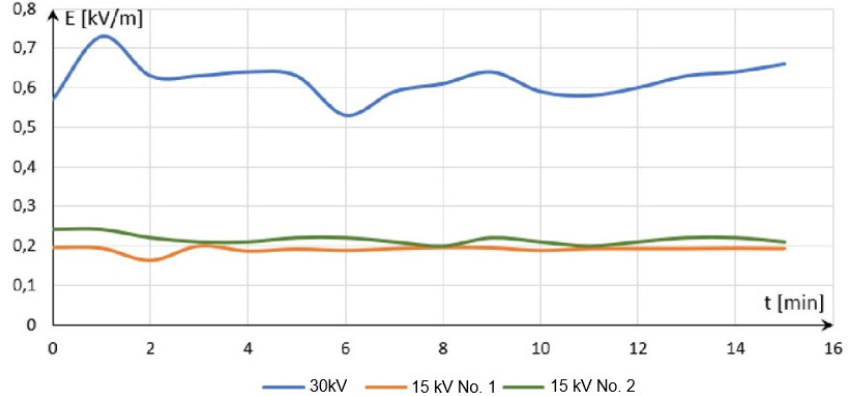
Figure 16. Electric field strength E fluctuations under MV lines supplying the container, for the ELF range (measurement methodology as in Figure 2).